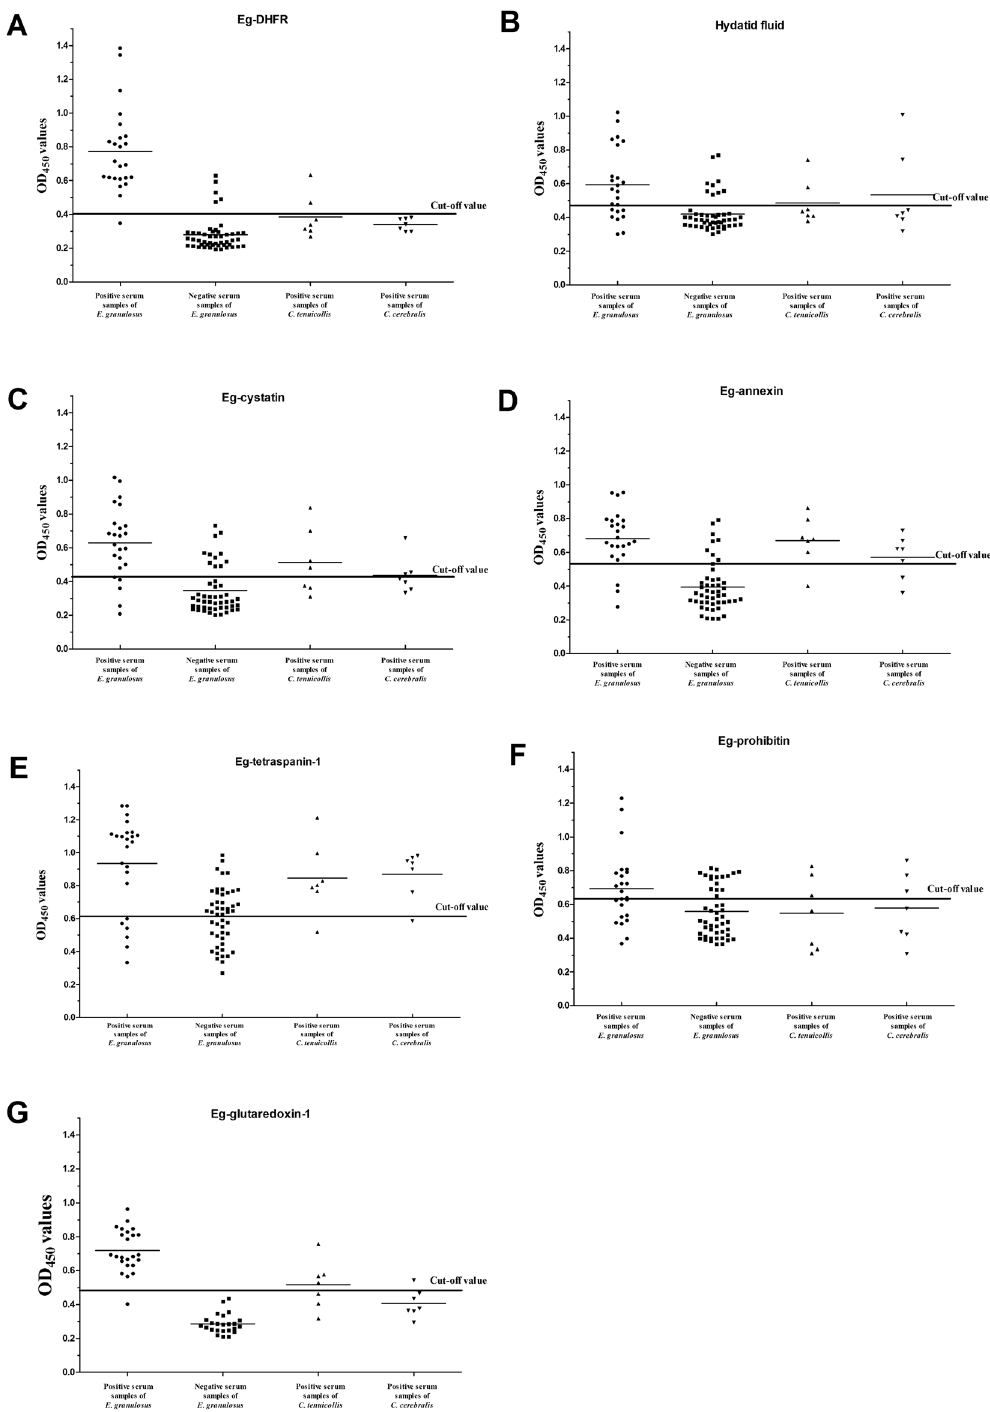
Figure 7. Indirect ELISAs (iELISAs) for the detection of cystic echinococcosis in sheep. ( A ) The rEg-DHFR iELISA. Statistically significant differences between E. granulosus -positive serum and the other positive sera were tested by one-way ANOVA using GraphPad Prism software (ANOVA: F (2, 35) = 17.21, P < 0.0001). A statistically significant difference between the E. granulosus -positive group and the negative group was determined by t -test ( t- test: t (70) = 12.04, P < 0.0001). P values < 0.05 were considered significant. ( B ) The hydatid fluid iELISA. ANOVA: F (2, 35) = 0.8212, P = 0.4482; t- test: t (70) = 4.708, P < 0.0001. ( C ) The rEg- cystatin iELISA. ANOVA: F (2, 35) = 3.019, P = 0.0617; t- test: t (70) = 6.765, P < 0.0001. ( D ) The rEg-annexin iELISA. ANOVA: F (2, 35) = 1.324, P = 0.2791; t- test: t (70) = 7.411, P < 0.0001. ( E ) The rEg-tetraspanin-1 iELISA. ANOVA: F (2, 35) = 0.4218, P = 0.6592; t- test: t (70) = 5.894, P < 0.0001. ( F ) The rEg-prohibitin iELISA. ANOVA: F (2, 35) = 1.684, P = 0.2003; t- test: t (70) = 3.078, P = 0.003. ( G ) The rEg- glutaredoxin-1 iELISA (Our previous published data, ref. 35.). ANOVA: F (2, 18) = 28.41, P < 0.0001; t- test: t (46) = 15.12, P <